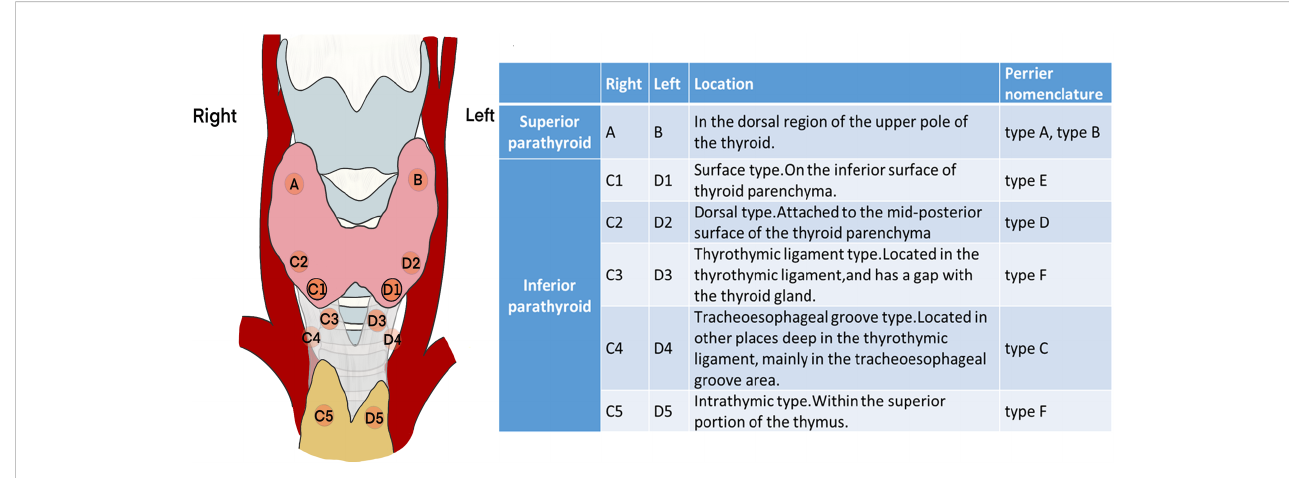
FIGURE 1 Classi fi cation and schematic diagram of the parathyroid glands according to the surgical exploration